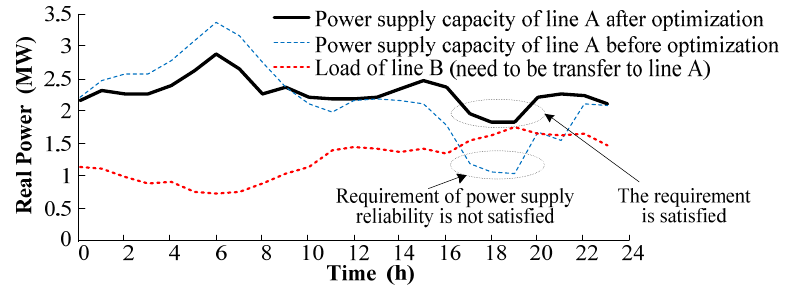
Figure 12. Power supply capacity of ADN Line A after optimization.